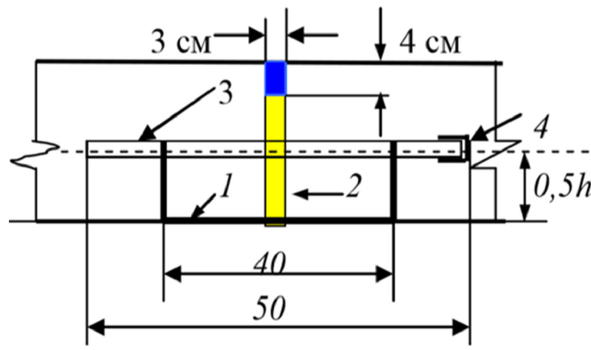
Figure 3: Expansion joint design (1 – bond transfer steel supporting rack; 2 – joint filler wood board; 3 – bond transfer steel; 4 – plastic cap)